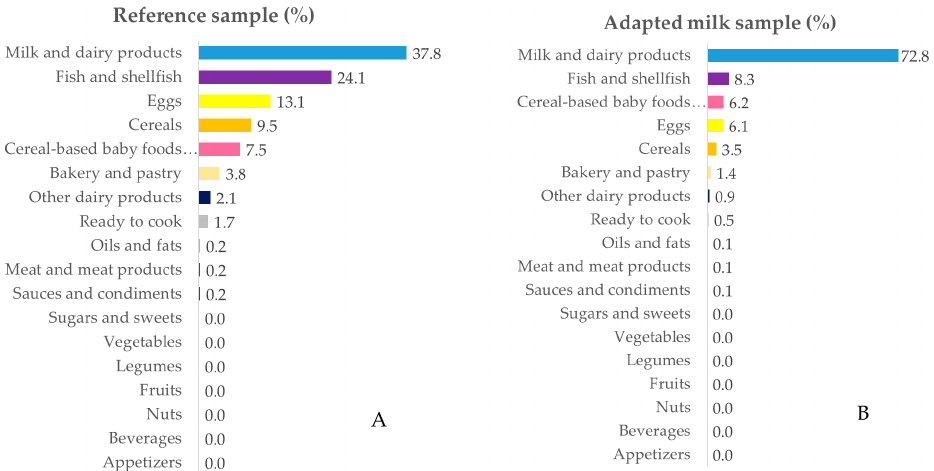
Figure 3. Percentage of the 18 food groups sources, in terms of the total magnesium intake (%), among the reference sample ( A ) and the adapted milk consumer sample ( B ) of the Spanish Pediatric Population (EsNuPI) study.